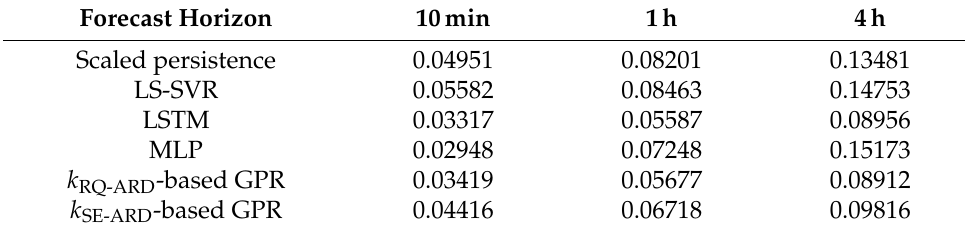
Table 3. DMAE values for all the models included in the comparative study.